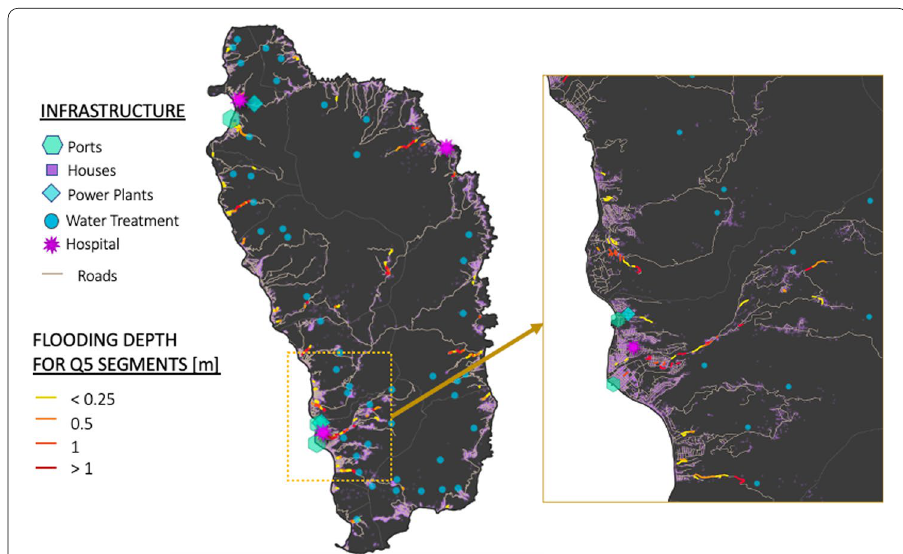
Fig. 4 Assessment of the risk of flooding to healthcare, shown for depth of flooding on road